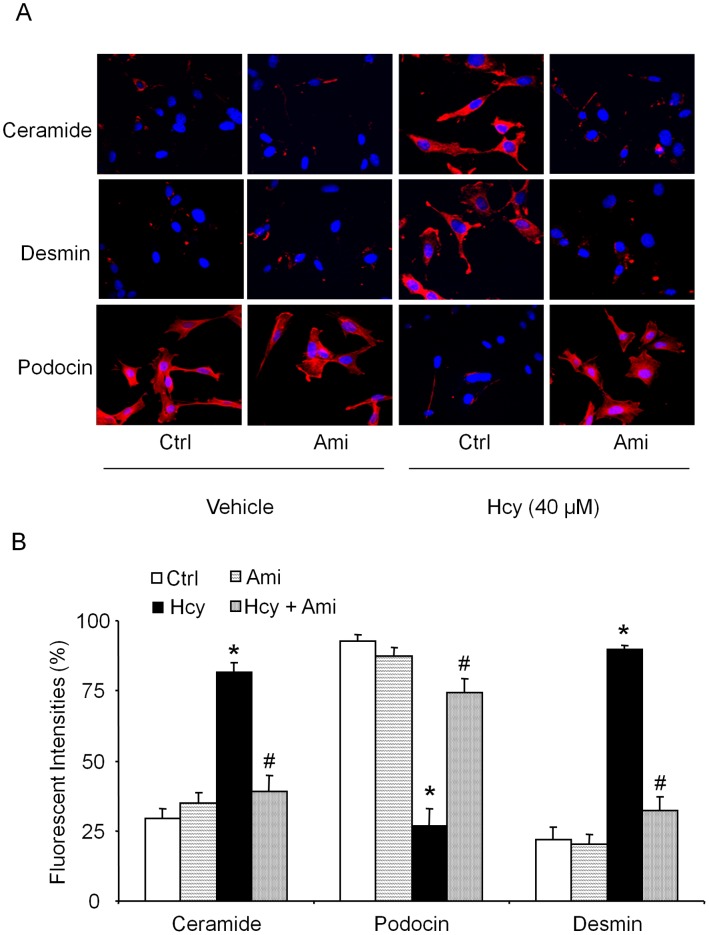
Production of ceramide, podocin and desmin staining in podocytes with or without Hcys and/or amitriptyline treatment.Cultured podocytes were treated with or without Hcys for 24 h. A: Typical fluorescent microscopic images of ceramide, podocin and desmin in Hcys and/or amitriptyline treated podocytes (n = 5/group, Original magnification, ×400). B: Values are arithmetic means ± SE (n = 5 each group) of summarized data showing the percentage of positive staining cells of ceramide, desmin and podocin vs. control group. Ctrl: Control, Hcy: Homocysteine, Ami: Amitriptyline. * Significant difference (P<0.05) compared to the control group; # Significant difference (P<0.05) compared to the Hcys group.